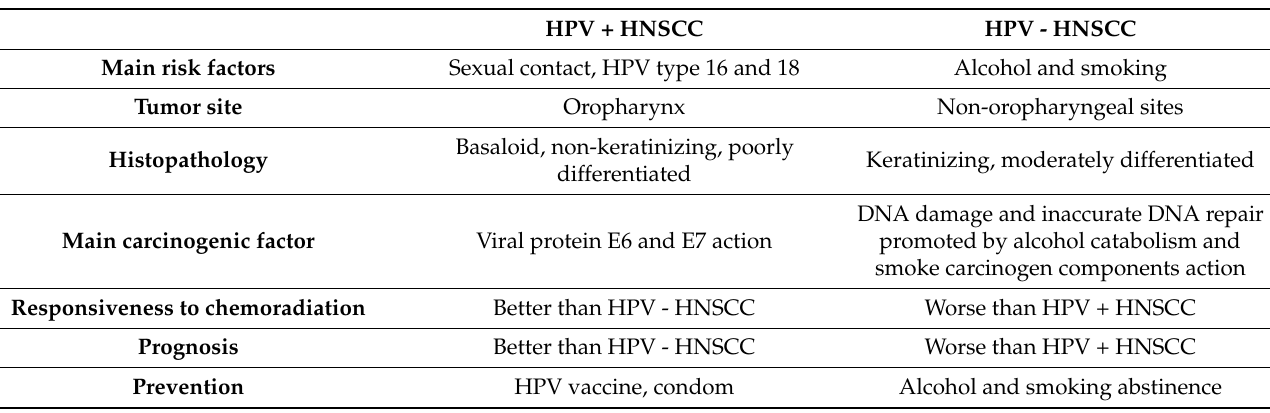
Table 1. Major differences between HPV + and HPV - HNSCC (mainly related to alcohol abuse and smoke). Alcohol is a major determinant of aggressive HNCs. HNSCC, head and neck squamous cell carcinomas; HPV, human